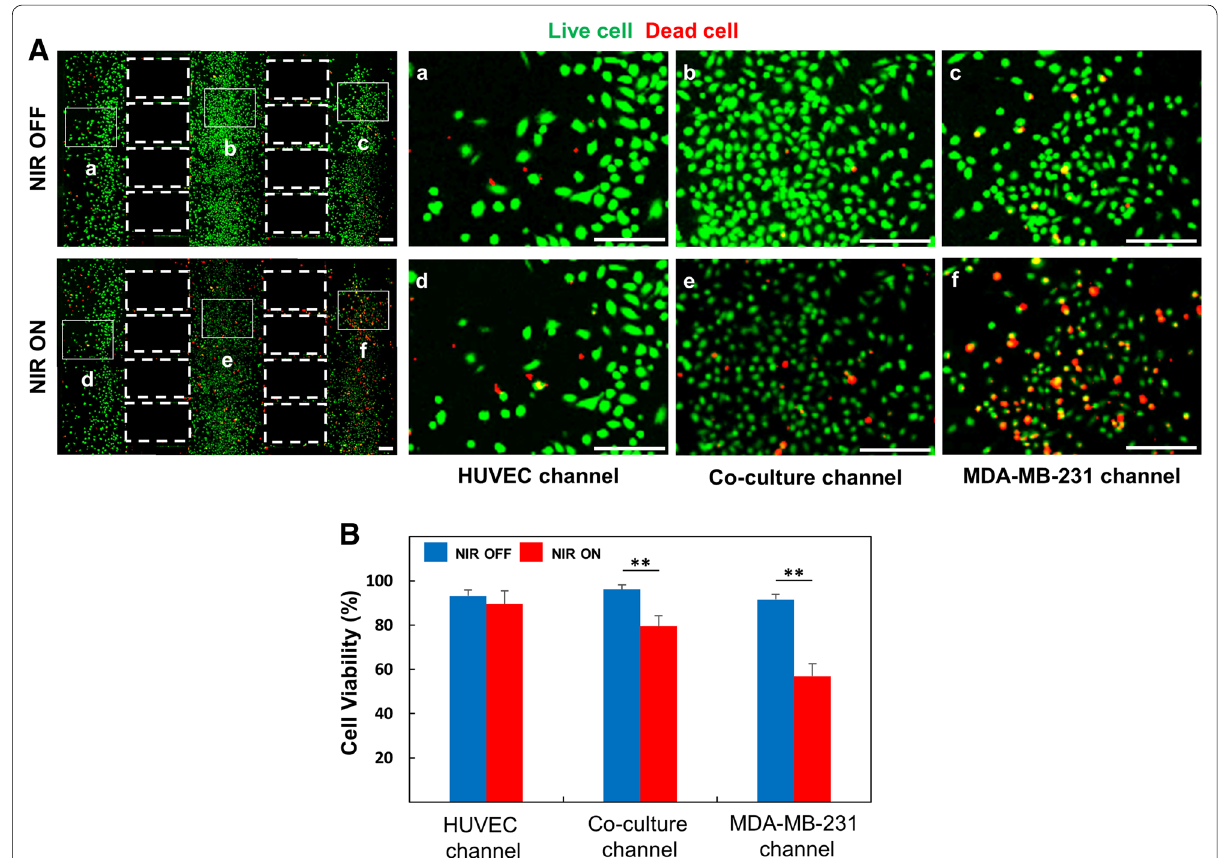
Fig. 7 Fluorescence image of live (green)/dead (red) before and after NIR laser irradiation after treatment with 30 μg/mL of rGO‑PEG‑FA nanomaterials in HUVECs and MDA‑MB‑231 breast cancer cells ( A ). High magnification image of the HUVEC (a, d), Co‑culture (b, e), and MDA‑MB‑231 (c, f) channel. Analysis of cell viability by fluorescence intensity in a microfluidic co‑culture platform ( B ) (* p < 0.05, ** p < 0.01).